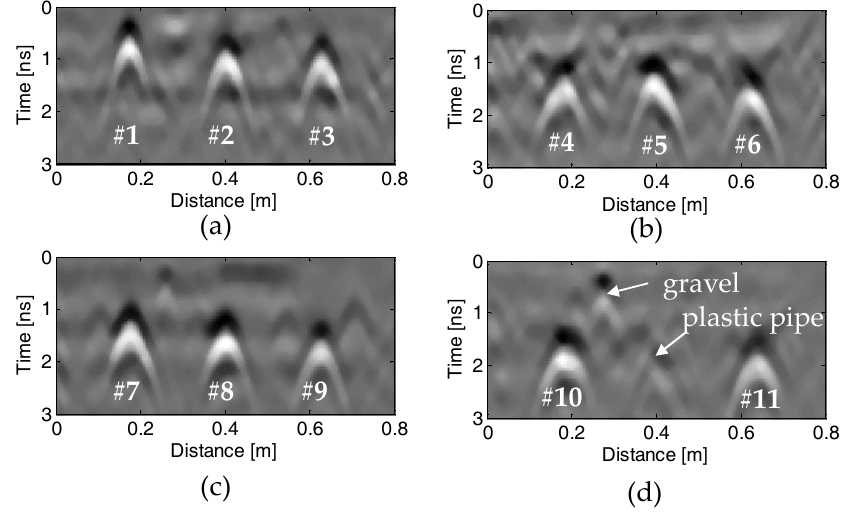
Figure 9. Recorded GPR profiles on the four concrete specimens ( a – d ) after pre-processing. The serial